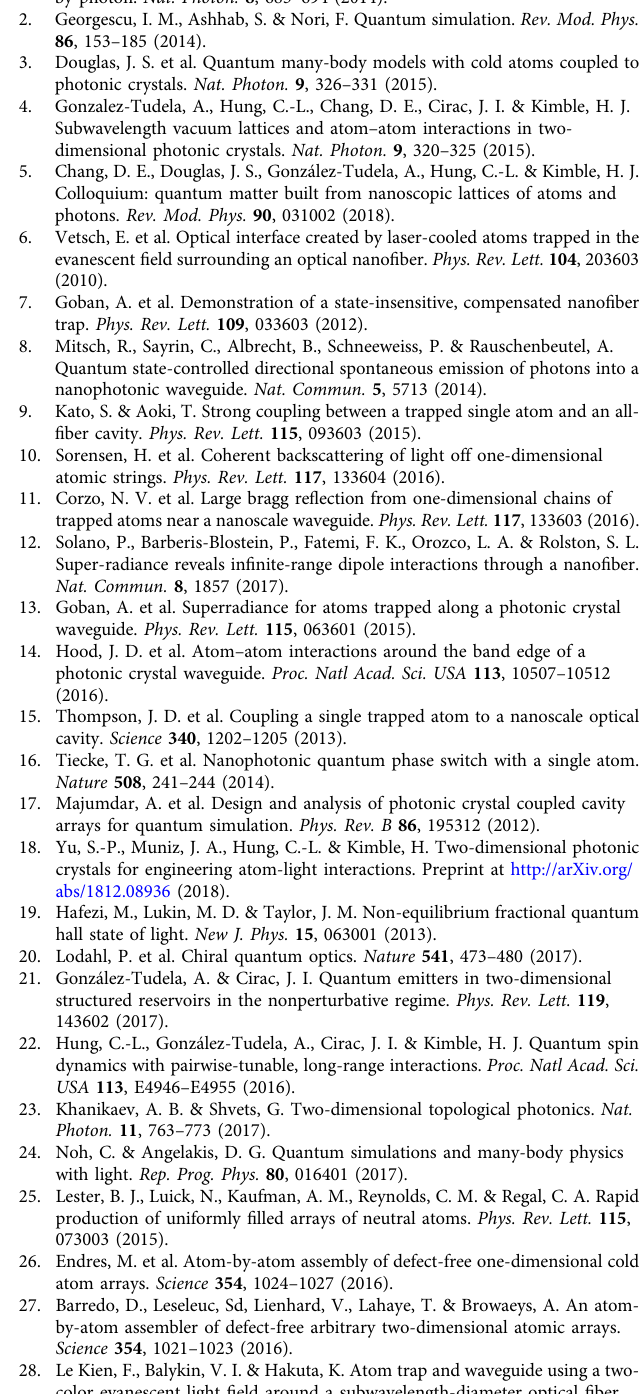
Fig. 3e, η 2 r rises up quickly approaching z ≈ 12 μ m. This could qualitatively explain why a quick reduction of fl uorescence counts is observed for Δ z f >0 in Fig. 3d. It is also suggestive that all atoms observed during the second imaging period in Fig. 2 should be trapped and imaged well within z <10 μ m. Monte Carlo simulation of tweezer lattice loading . To estimate trap loading ef fi ciency and probability distribution within a tweezer lattice, we perform Monte Figs. 1 and 3. Actual loading ef fi ciency with PGC may differ from this calculation. We include the effect of atom-surface interactions by approximating the